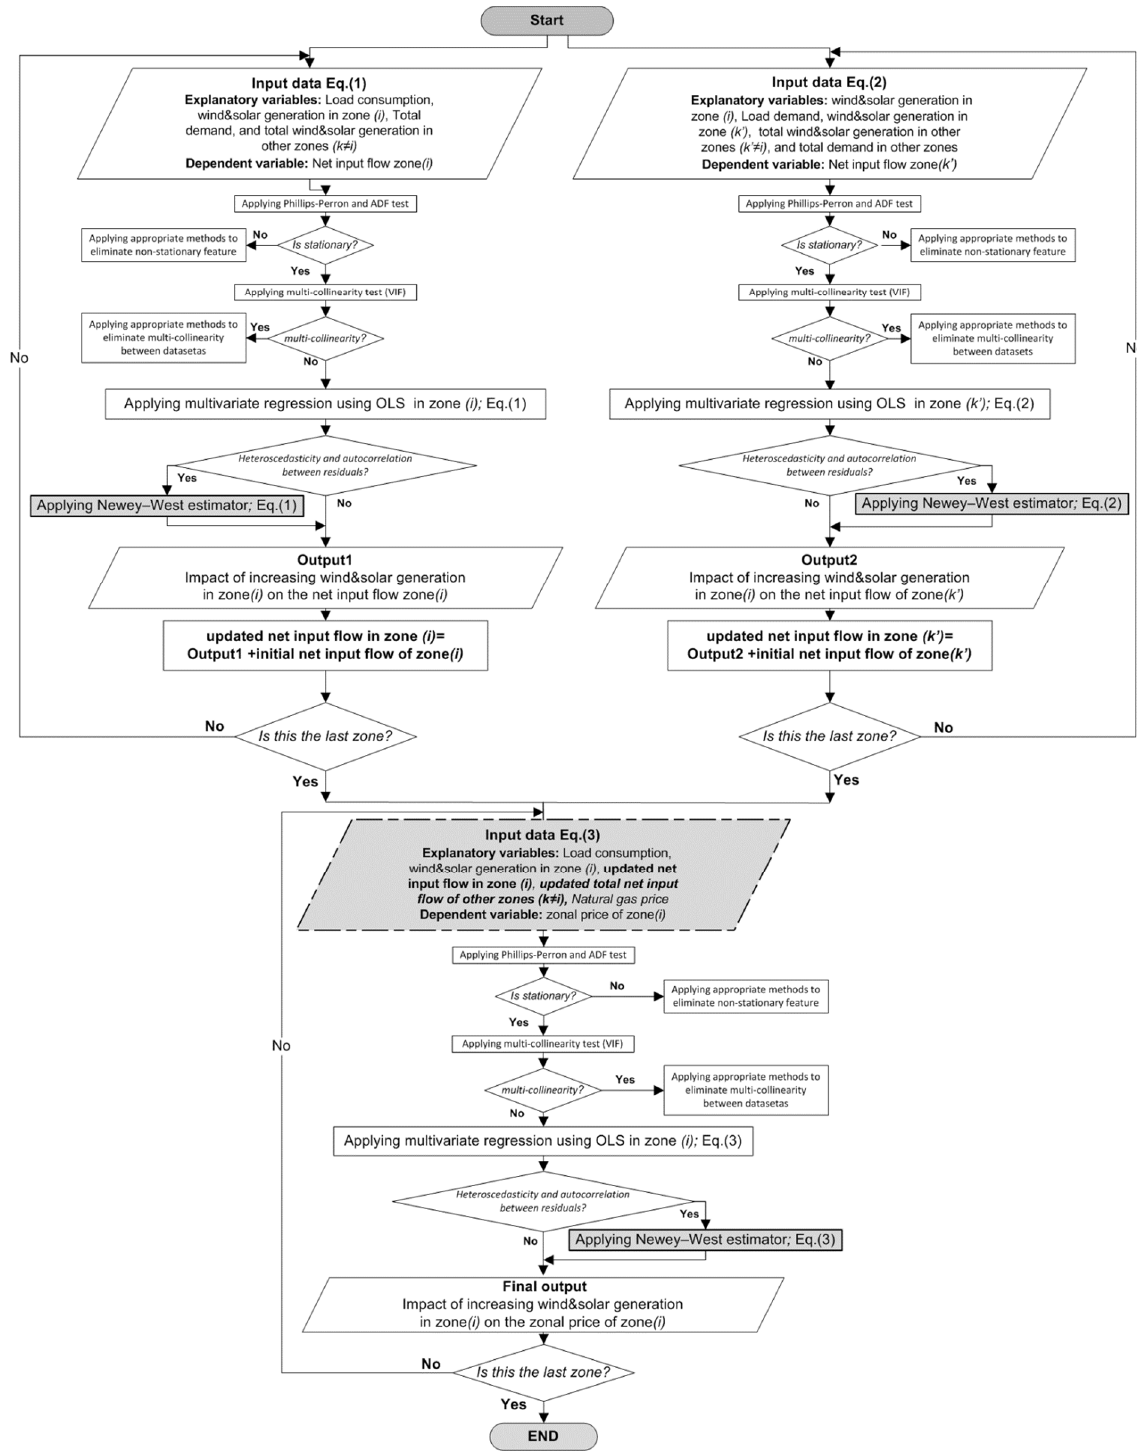
Figure 5. Diagram of the simulation procedures.